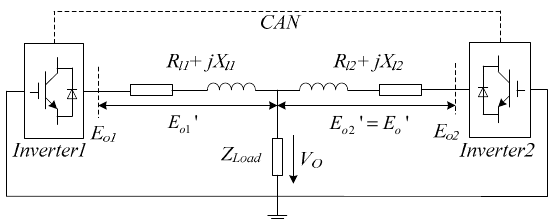
Figure 2. Single-line diagram of two inverters in parallel with different line impedance.